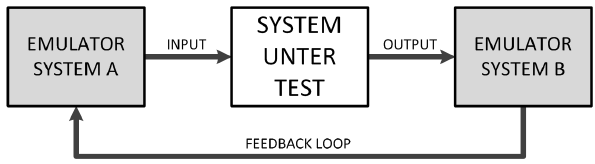
Figure 1. Generic setup of a X-in-the-loop as a concept for system